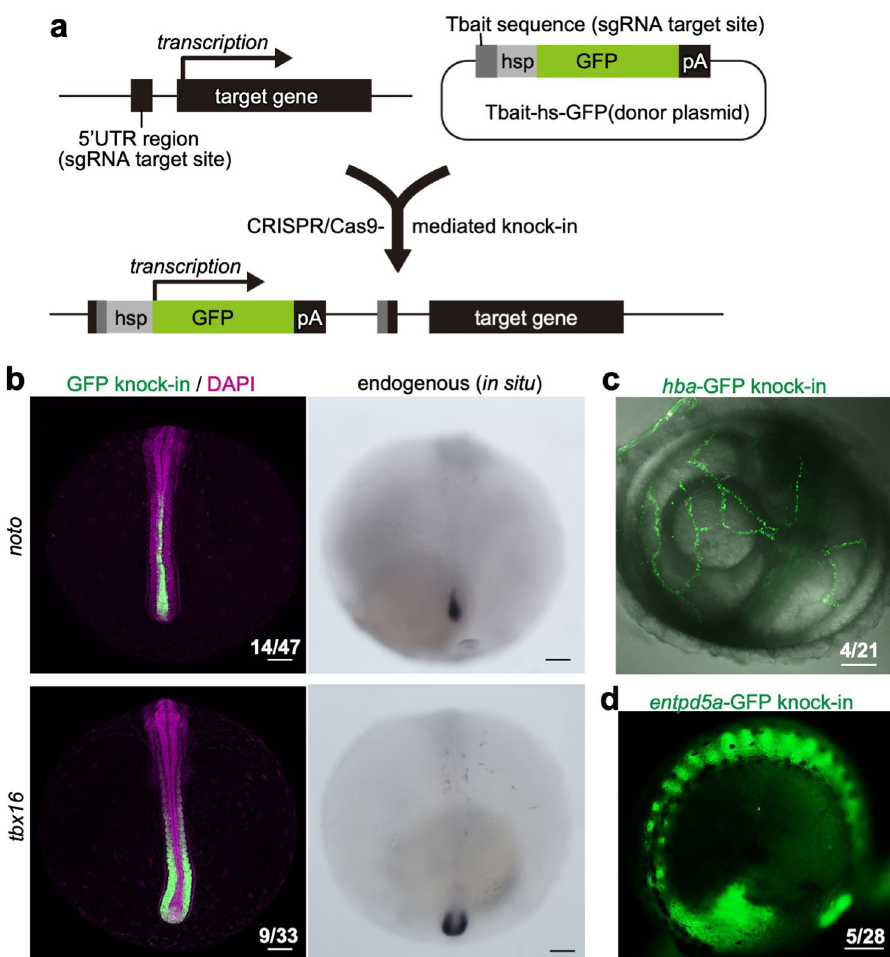
Figure 4. CRISPR/Cas9-mediated generation of reporter knock-in in N. furzeri . ( a ) Two sgRNAs for digesting the 5’ UTR region of the target gene and donor plasmid, respectively, were designed for generating